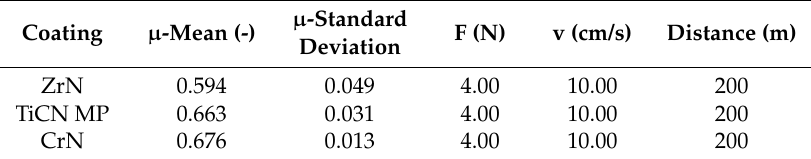
Table 5. Pin-on-Disc test results.